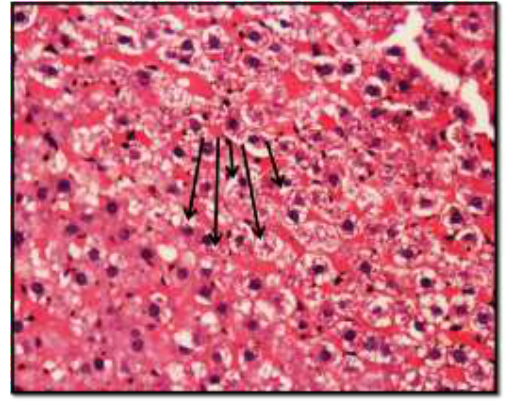
Figure 5b: Photomicrograph of Sudan black stained 5 µm thick frozen liver section is showing Fat droplets (black) of rat on high-fat diet + Ginseng 100mg/kg (group 3) at